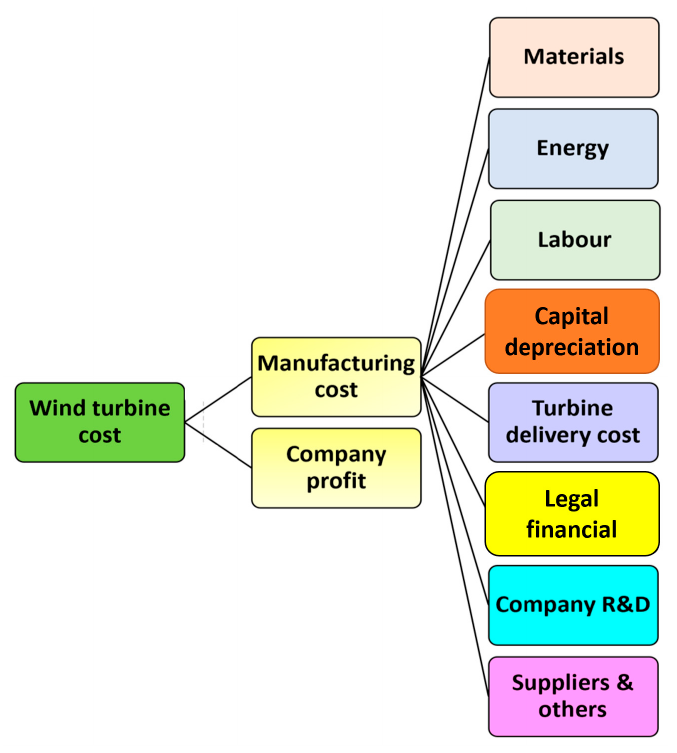
Figure 18. Evaluation of wind turbine cost [175].